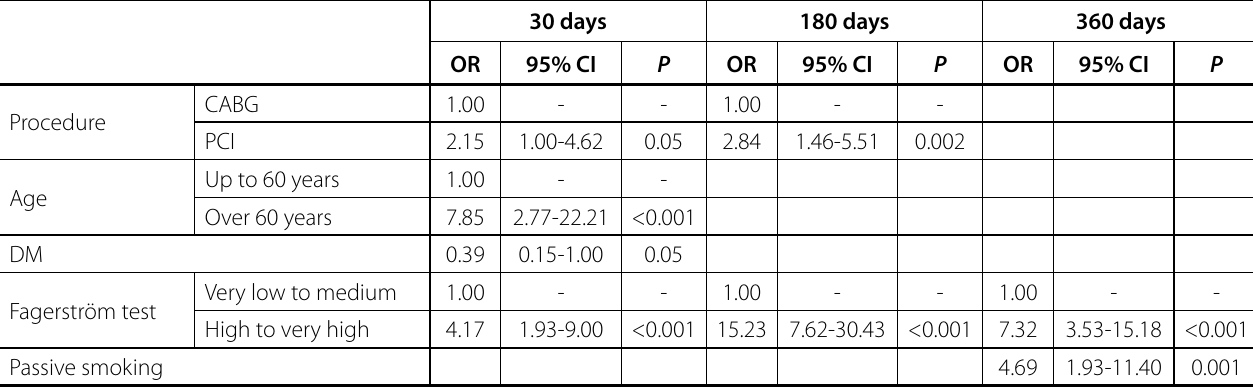
Table 4. Multivariate logistic regression model.